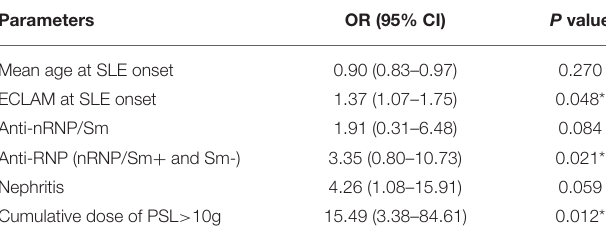
TABLE 3 | Multivariate logistic regression analysis of parameters for